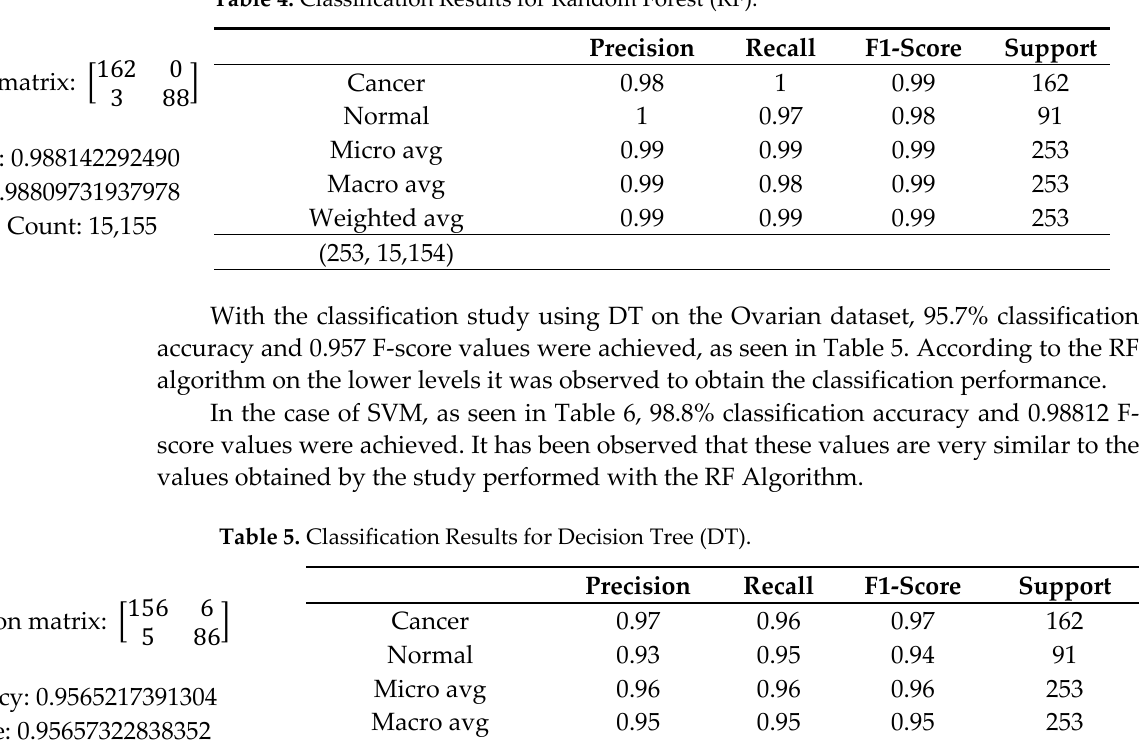
Table 4. Classification Results for Random Forest (RF).